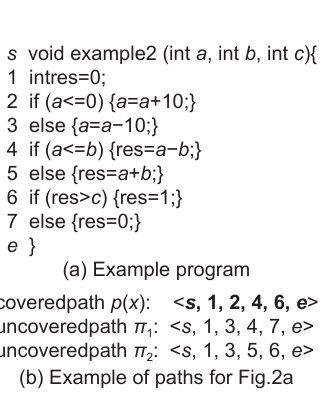
Fig. 2 Example of a program and some of its